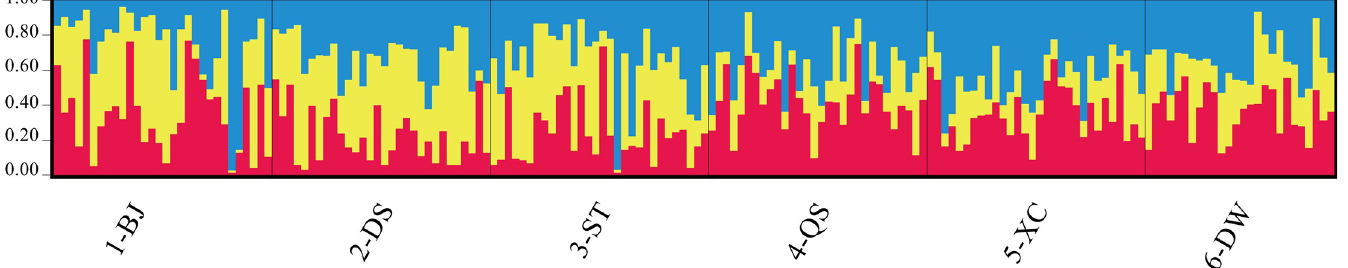
Fig 2. Bayesian assignment proportions for K = 3 genetic clusters determined in STRUCTURE, three clusters were represented by red, blue and yellow respectively.